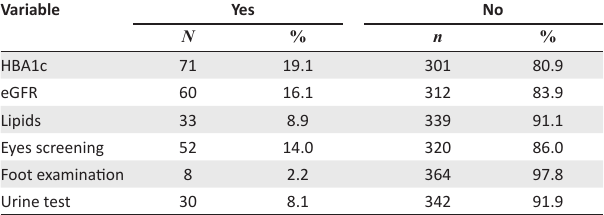
TABLE 1: Participants’ characteristics. TABLE 2: Screening for complications among participants in the past 12 months.